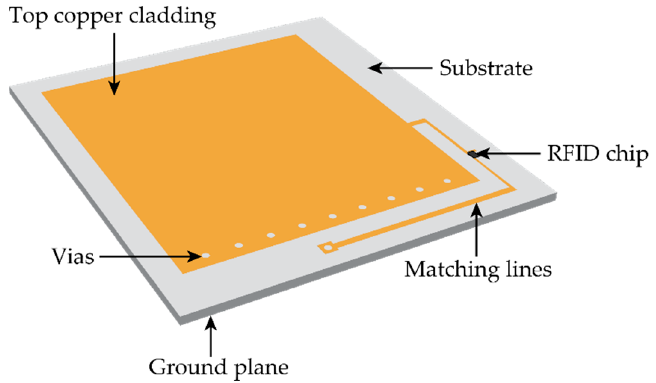
Figure 3. Illustration of the patch antenna sensor.